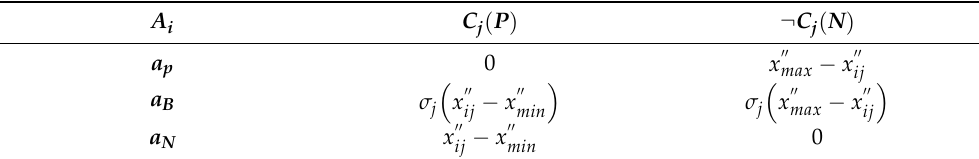
Table 3. Relative loss function of attribute values.